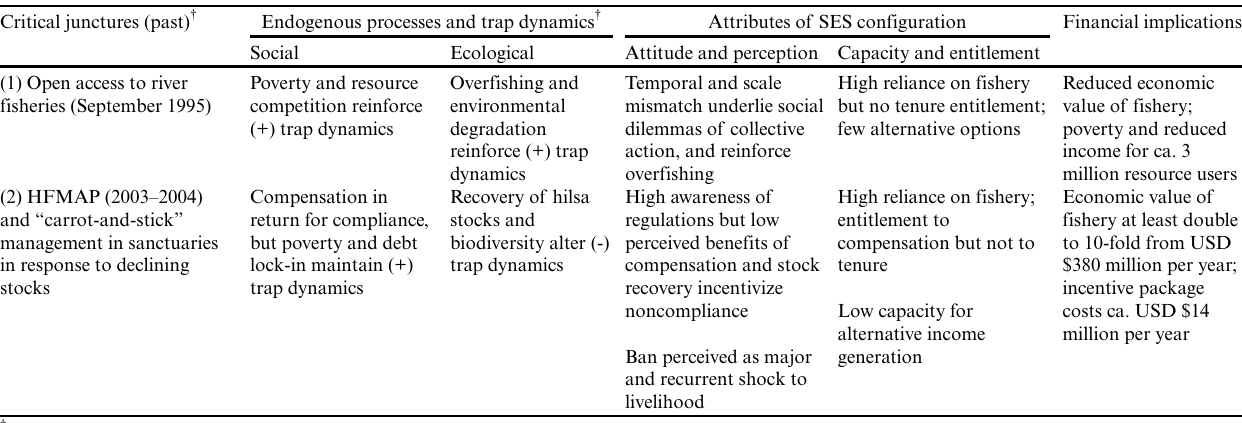
Table 1. Critical junctures and endogenous processes (social and ecological) that have influenced trap dynamics, perception, and capacity-based attributes of each SES configuration, and its financial